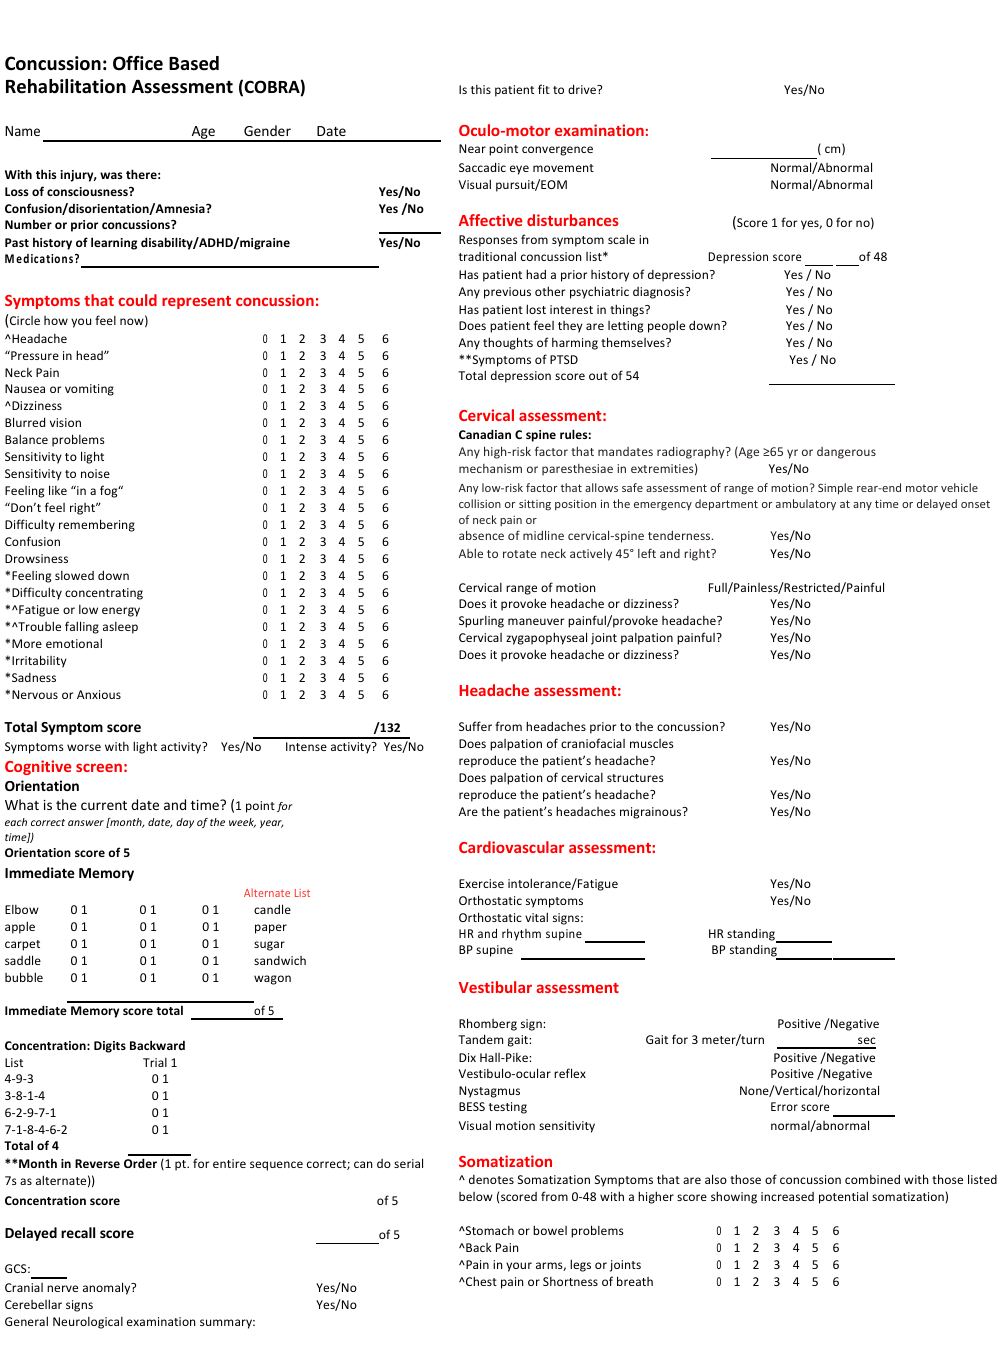
Figure 1. The Concussion Office Based Rehabilitation Assessment (COBRA).